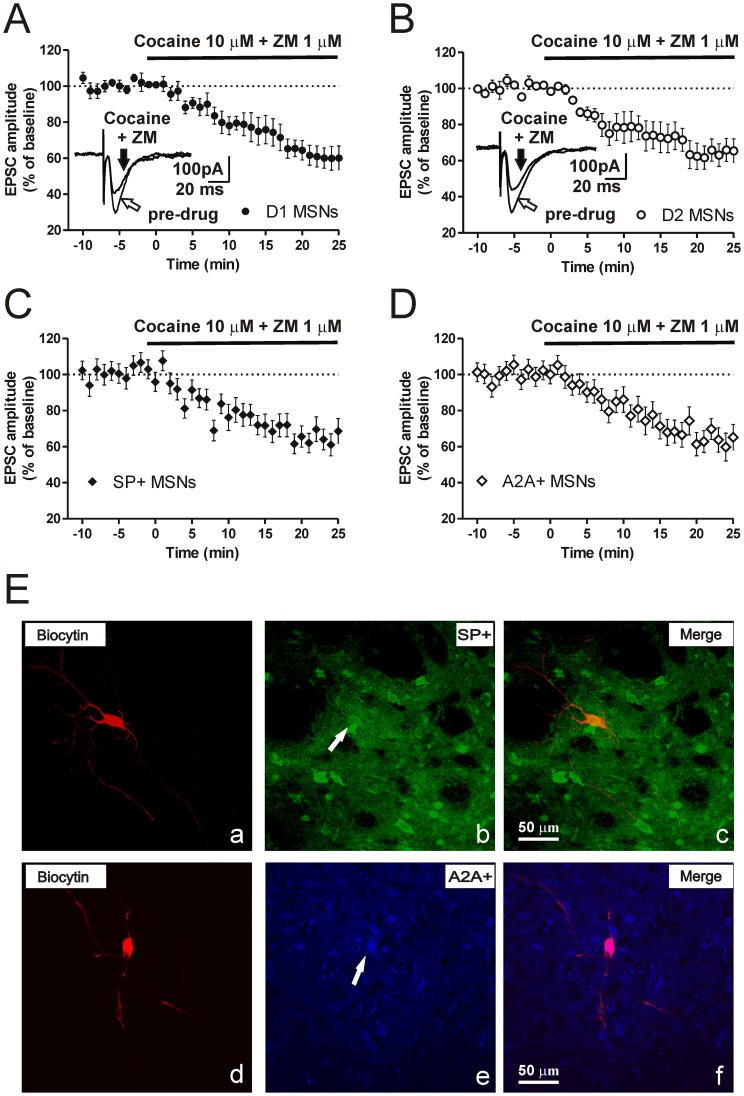
Cocaine and A2A-R pharmacological modulation affects excitatory synaptic transmission in both D2-and D1-receptor expressing striatal MSNs.Time-course plots of the EPSC amplitude and EPSC superimposed pairs recorded in the presence of cocaine plus ZM in D1-EGFP MSNs (A) and in D2-EGFP MSNs (B). Effect of cocaine plus ZM co-application on the time-course of EPSC amplitude recorded in substance P (SP) positive (C) and A2A positive (D) MSNs. (E) Representative images from confocal laser scanning microscopy of the immunofluorescence from a biocytin and SP containing MSN (top) and from a biocytin and A2A-R containing MSN (bottom) and the relative merged images.